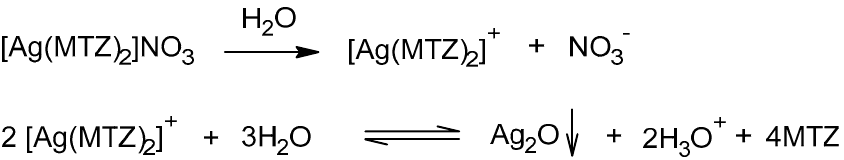
Scheme 1. Dissociation of silver (I) nitrate complex with metronidazole and cation [Ag(MTZ) 2 ] +